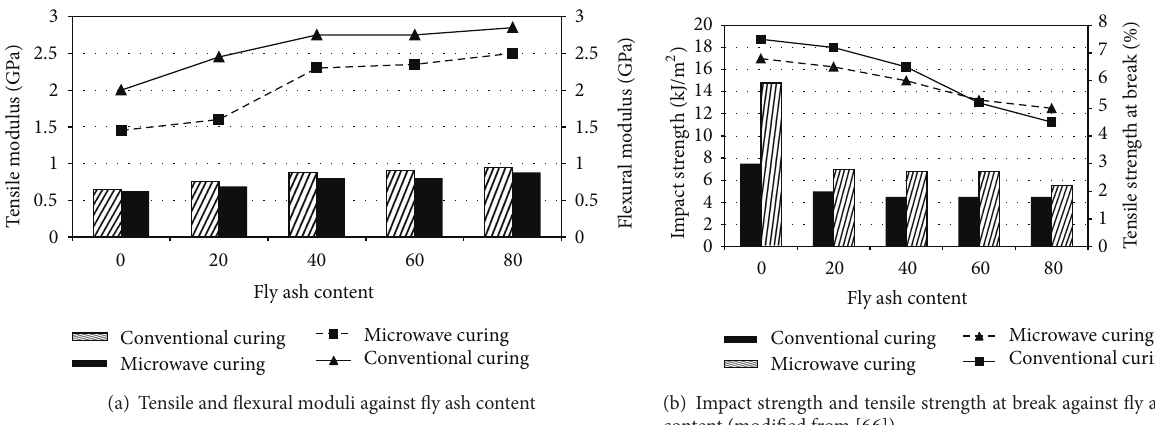
Figure 3: Effect of fly ash content on tensile, flexural moduli, and impact and tensile strength for conventional and microwave cured of fly ash/epoxy composite.